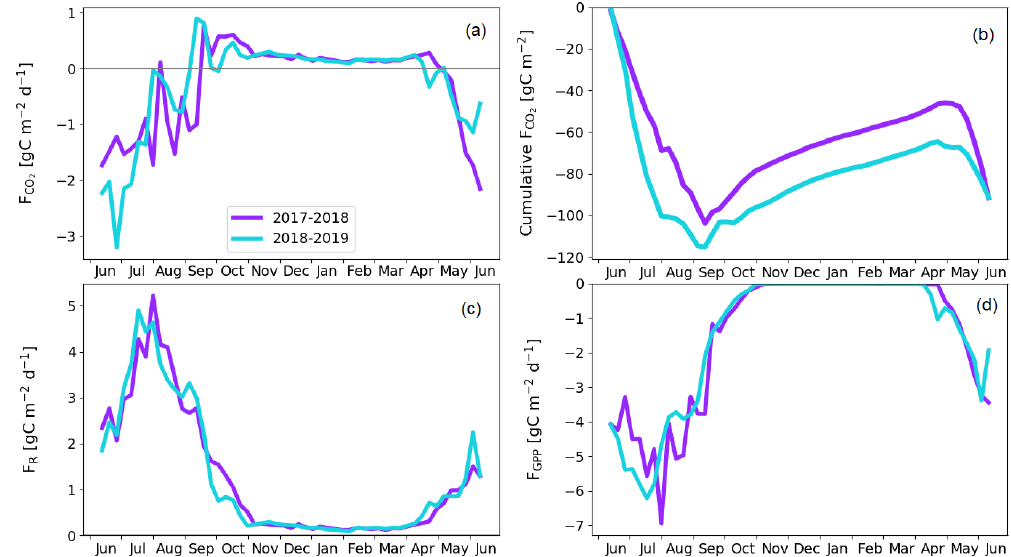
Figure 11. Treed pine bog gap-filled fluxes. Weekly averaged CO 2 flux (a) and cumulative CO 2 flux (b) . Weekly averaged ER (c) and GPP (d)